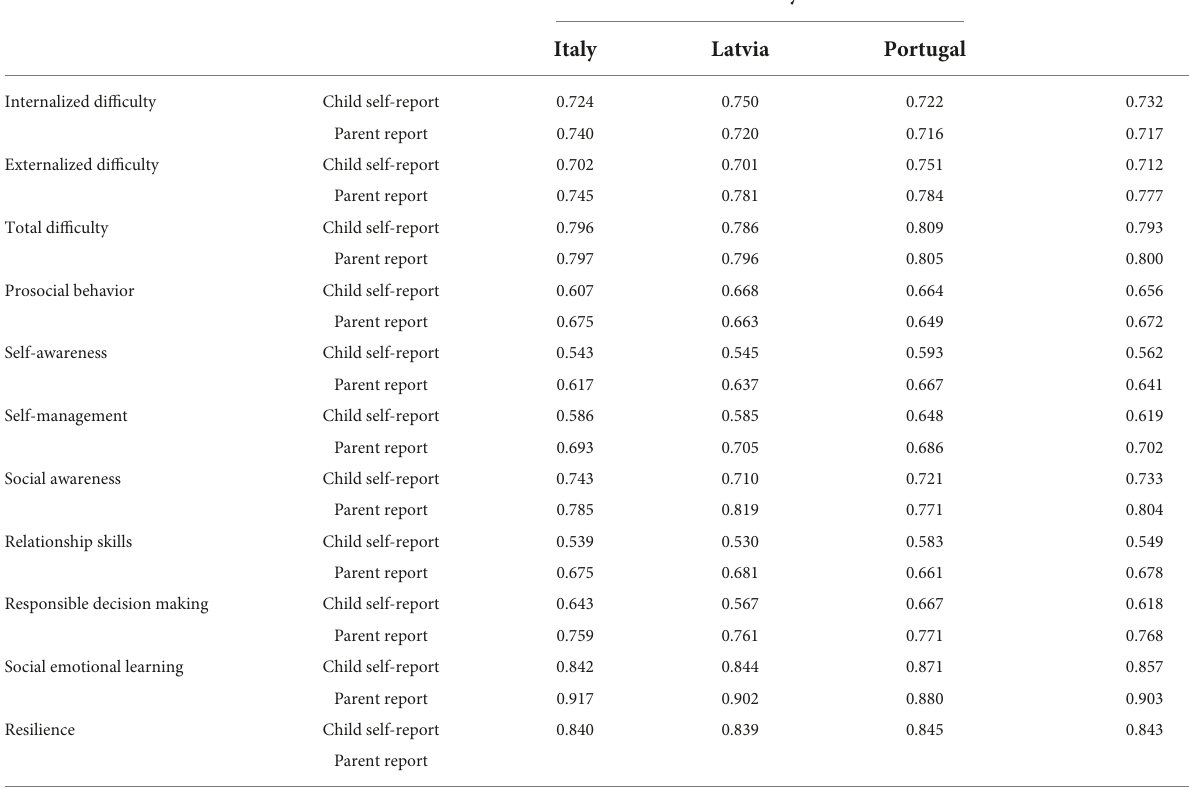
TABLE 4 Reliability of SDQ, SSIS-SEL, and CD-RISC-10 scales (Cronbach’s alpha). Subscale